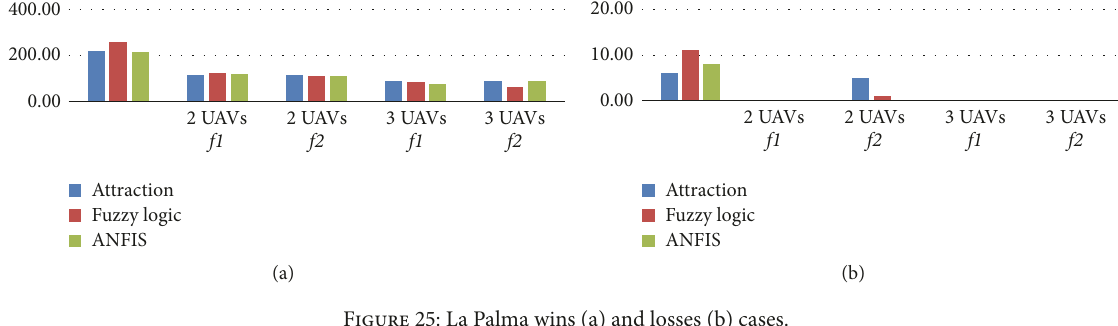
Figure 25: La Palma wins (a) and losses (b)